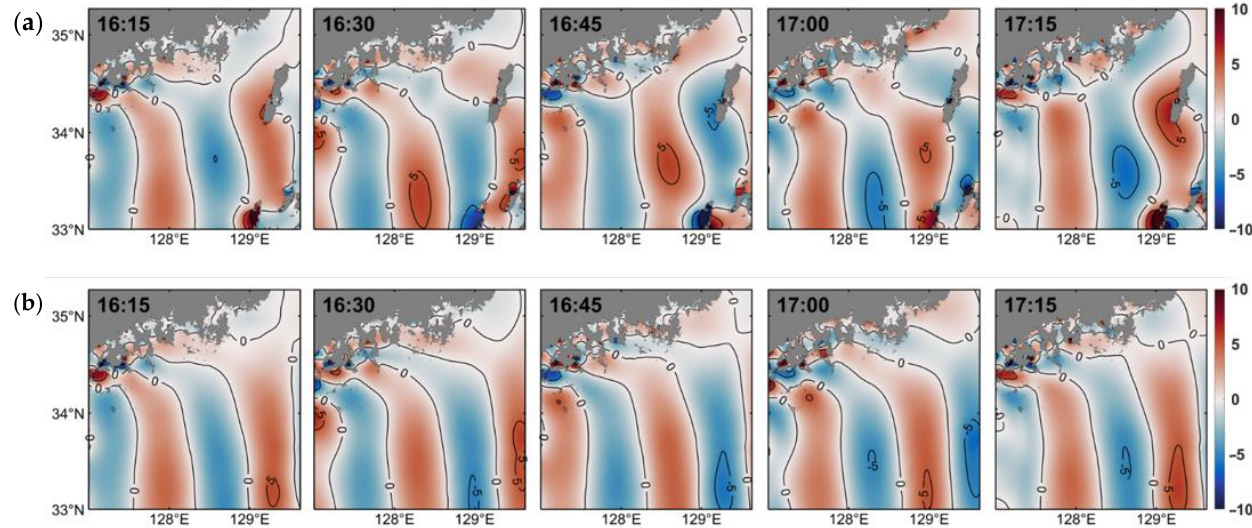
Figure 9. Spatial distributions of surface elevation every 15 min from 16:15 to 17:15 on 7 April 2019. The upper and lower panels are ( a ) surface elevation from the original topography (CON) and ( b ) no offshore island (NOI) models, respectively. The contour intervals of surface elevation are 5 cm.